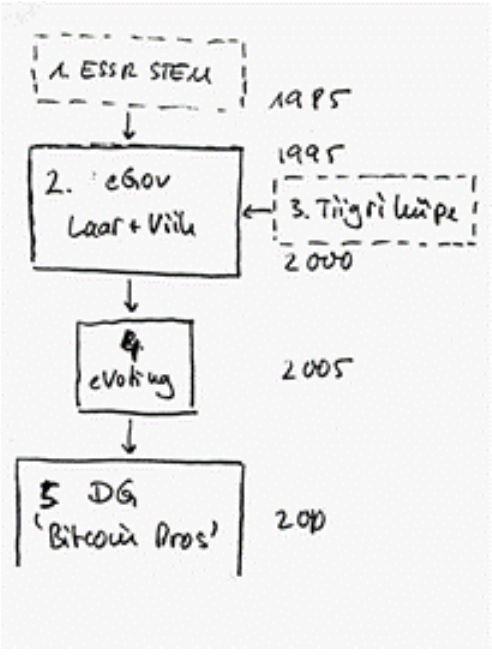
Table 2: A rough sketch of the history of